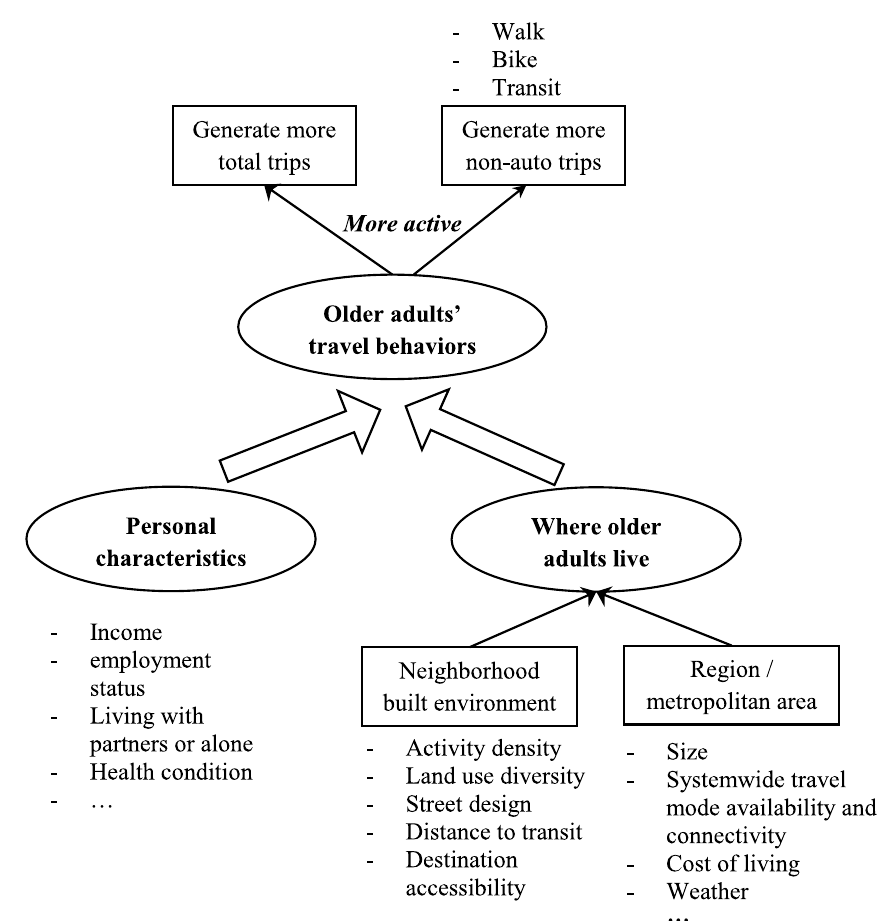
Fig. 1 Conceptual framework of older adults being